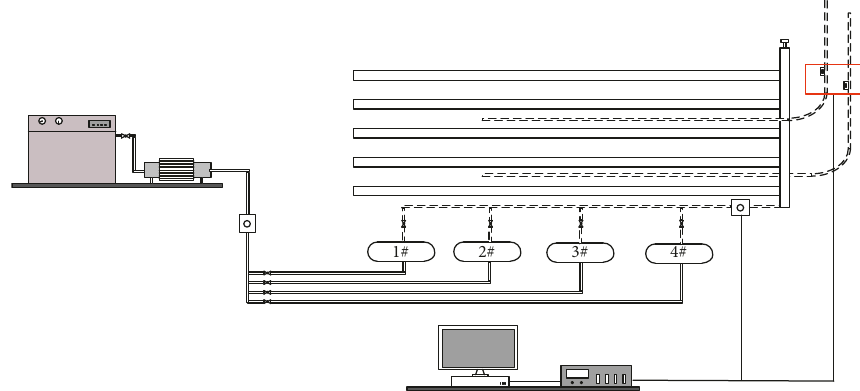
Figure 8: Experimental